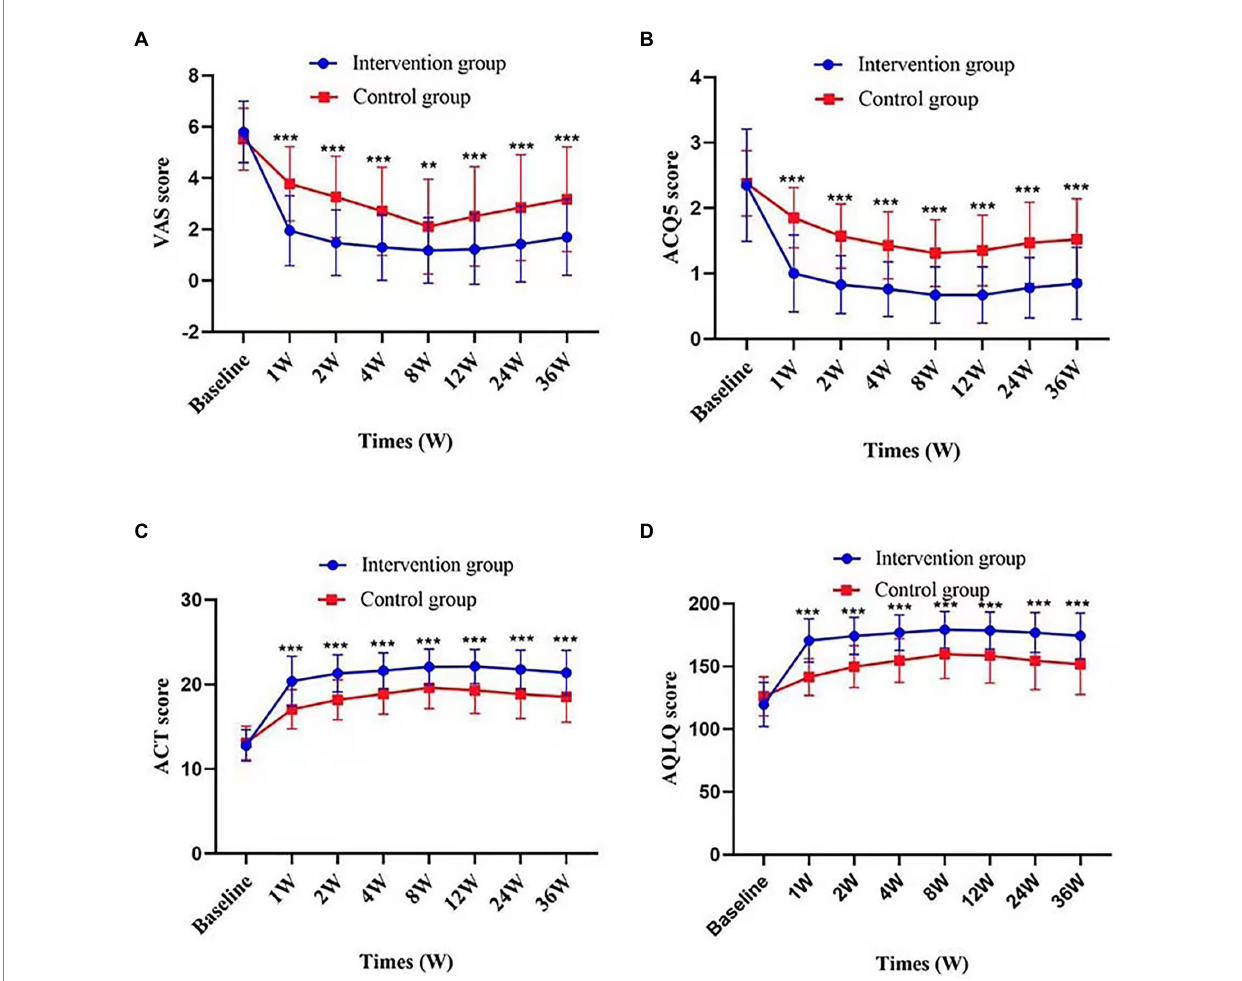
FIGURE 3 Change in VAS score, ACQ5score, ACT score, and AQLQ score according to times and groups. Figures demonstrate values of VAS score (A) , ACQ5 score (B) , ACT score (C) , and AQLQ score (D) at each time point in intervention group and control group. Values are presented as mean (SD). p value represents the independent samples t -tests comparing changes between the two groups. ** p value <0.01; *** p value <0.001, comparison between the two